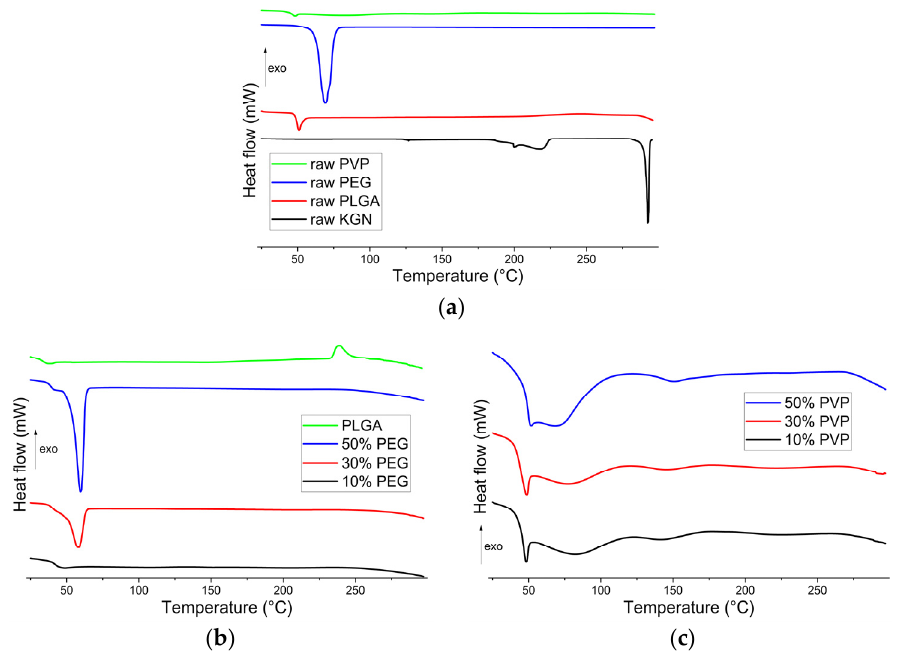
Figure 3. DSC patterns of ( a ) the raw materials (PLGA, PEG, PVP, and KGN); ( b ) KGN ‐ PLGA and KGN ‐ PLGA/PEG particles; and ( c ) KGN ‐ PLGA/PVP particles.